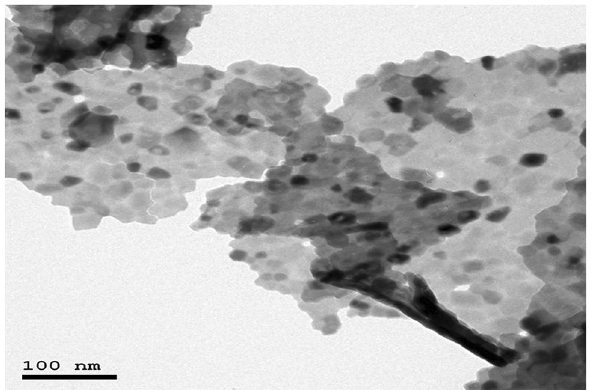
Figure 3. TEM image of Erbium Oxide